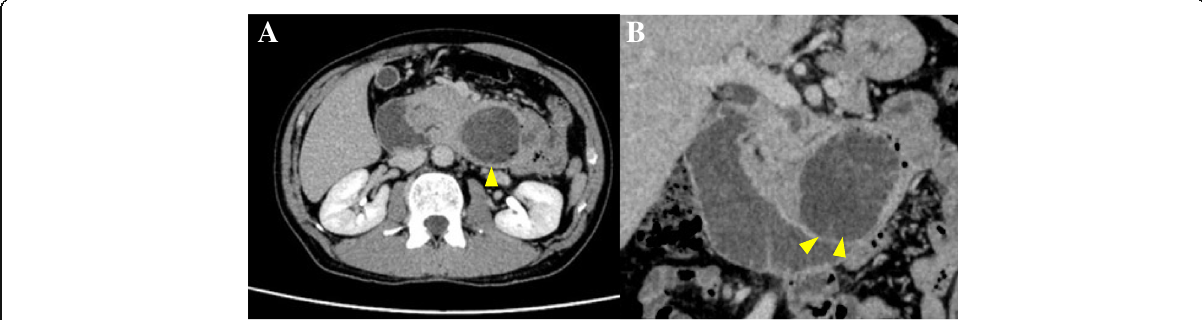
Fig. 1 Abdominal CT showed 6 cm low-density mass in the retroperitoneum, in all phase (arrow). a Coronal view showed gastroduodenal invagination. b Duodenum proximal to the mass is dilatated